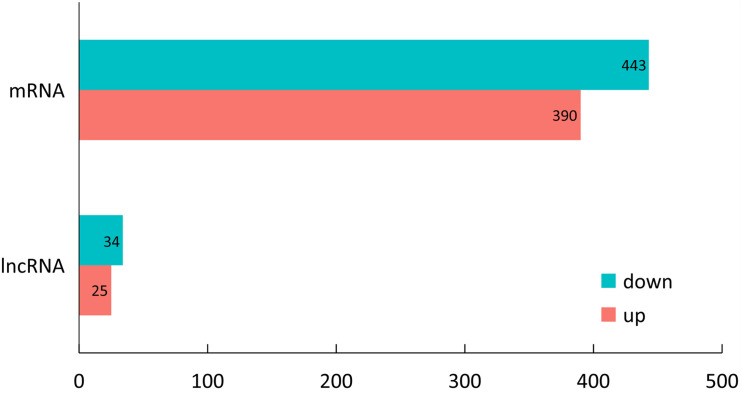
Number of upregulated and downregulated DEGs and DELs of LP vs DP.